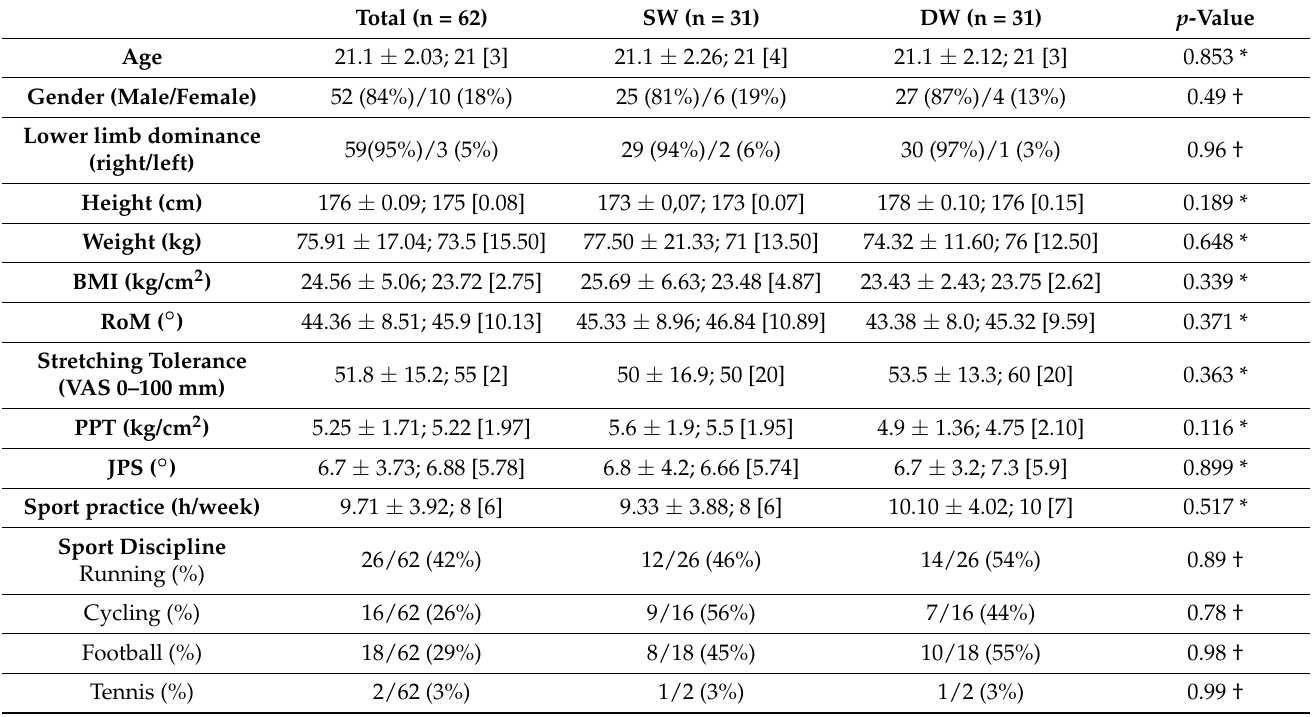
Table 1. Characteristics of the participants.